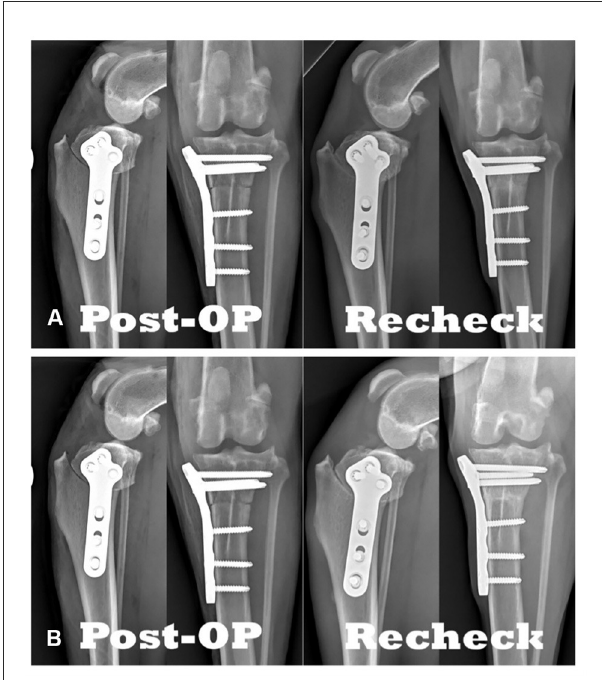
FIGURE2 Comparison of TPLO radiographs: (A) Immediately postoperative compared to 8-weeks postoperative. (B) Immediately postoperative compared to 6-weeks postoperative.